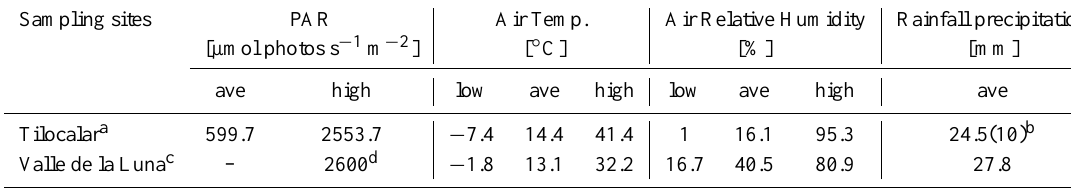
Table 1. Annual averages for climate data at Tilocalar (rhyolite) and Valle de la Luna (calcite) rocks. Sampling sites